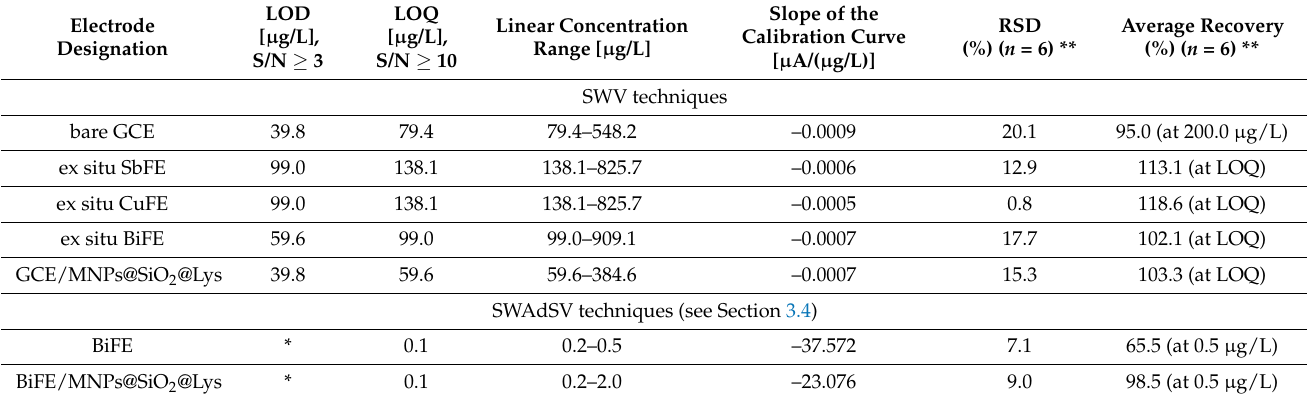
Table 1. A comparison of results obtained for the determination of Cr(VI) by various electrodes (the RSD and average recovery values were obtained at the concentration reported in brackets for the average